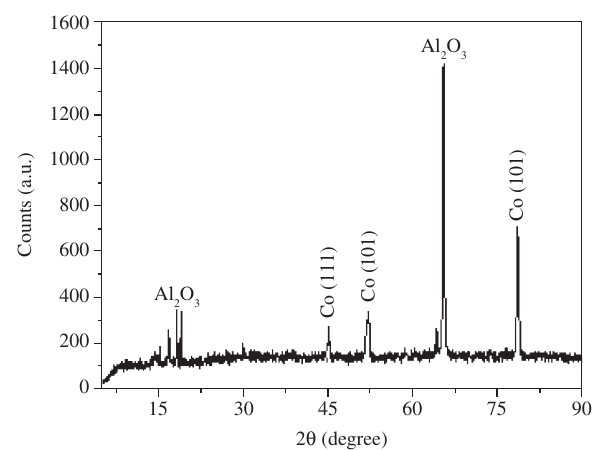
Figure 2. X ray diffraction profile of Co nanowire/AAM. Figure 3. AFM micrographs of Co nanowires: a) Topographic; b) Phase Im- age; and c) profile along the indicate